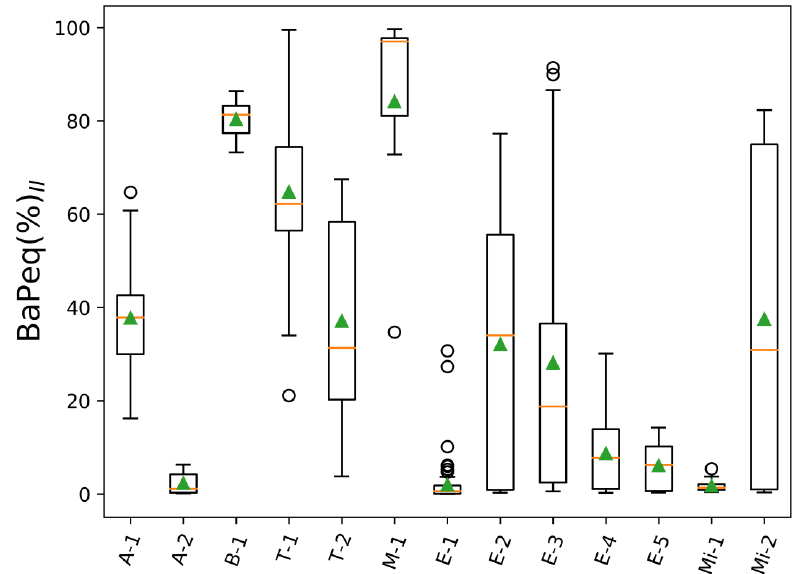
Figure 3 . BaPeq ratios of 16 EPA priority particle-phase PAHs to 16 EPA priority PAHs in both gas and particle phases (BaP eq (%) II = PM∑ 16EPA BaP eq /(PM + Gas)∑ 16EPA BaP eq ); orange lines—mean values of BaP eq (%) II ; green triangles—median values of BaP eq (%) II .